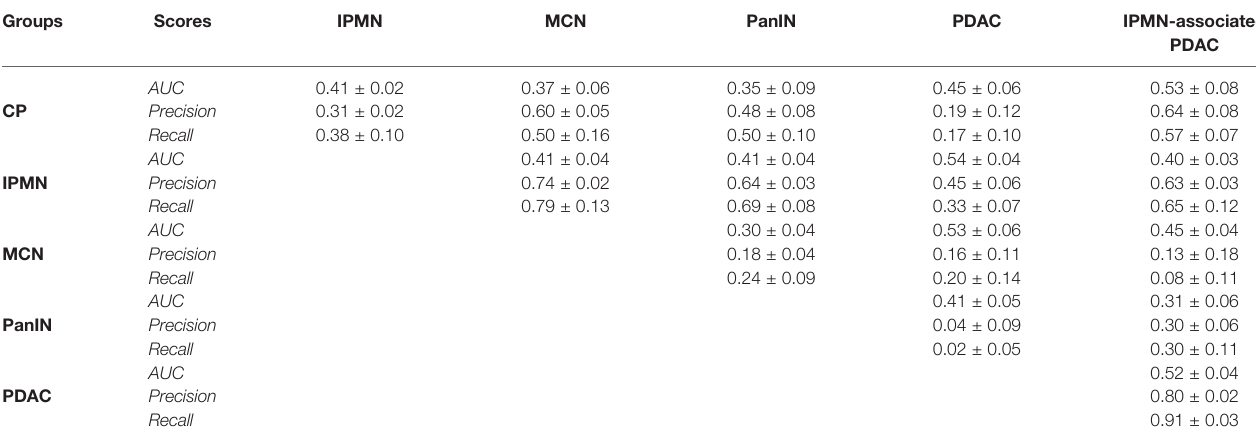
TABLE 4 | Classi fi cation metrics for the 15 pairwise decision-tree classi fi ers based on the Morisita-Horn index values from every point pattern set from each disease group.